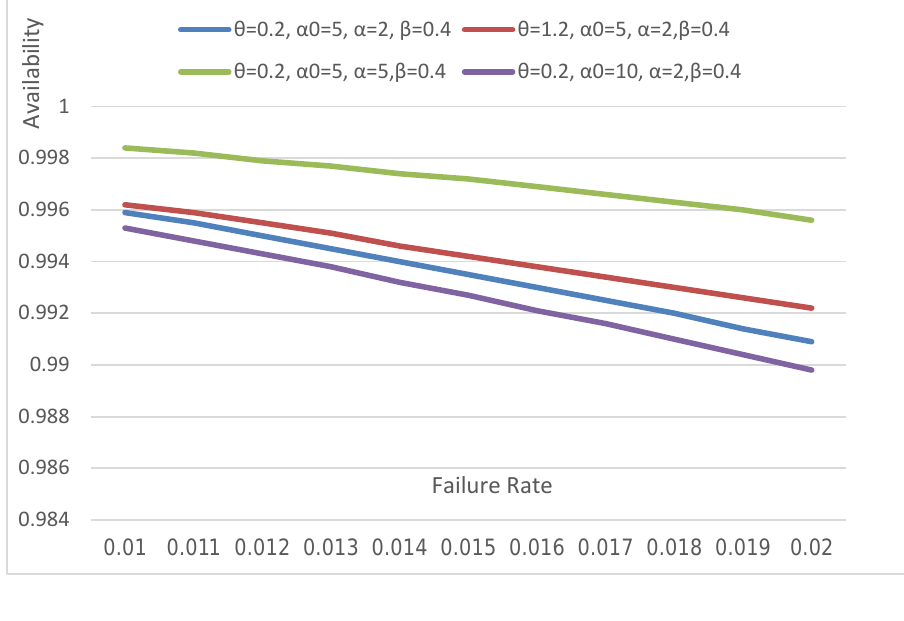
Fig. 2. Availability vs. Failure Rate